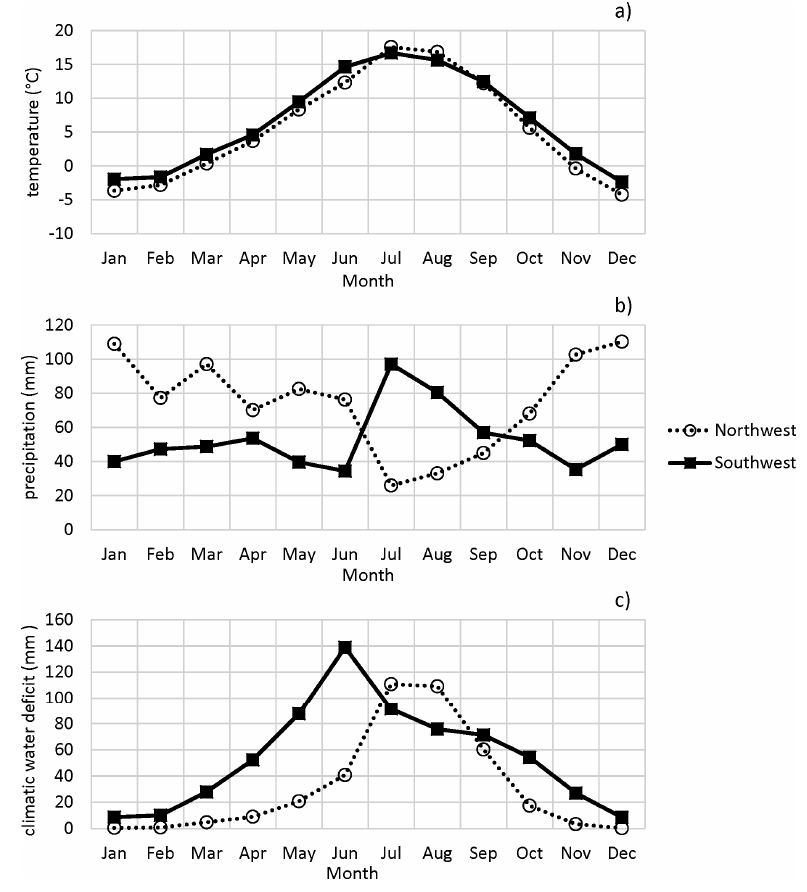
Figure 4. Average monthly climate of the Northwest and Southwest regions from 1997 to 2015: ( a ) temperature, ( b ) precipitation, and ( c ) climatic water deficit. Circles and dotted lines represent average climate metrics of Northwest regions, and squares and solid lines represent average climate metrics of Southwest regions.